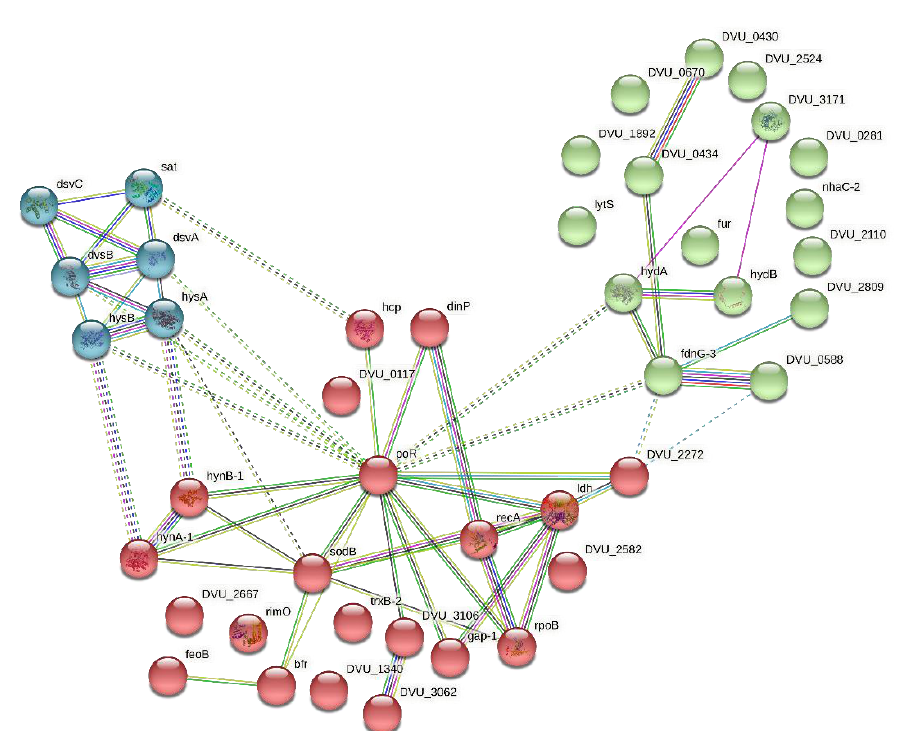
Figure 3. The PPI network demonstrates three cluster formations. Cluster 1 (red) shows the genes involved in metal ion binding and oxidoreductase activity. Cluster 2 (green) represents the genes participating in cellular respiration, oxidation-reduction activity, and electron transport. Lastly, cluster 3 (cyan) displays genes engaged in oxidoreductase, hydrogenase and hydrogensulfite reduc- tase activity.